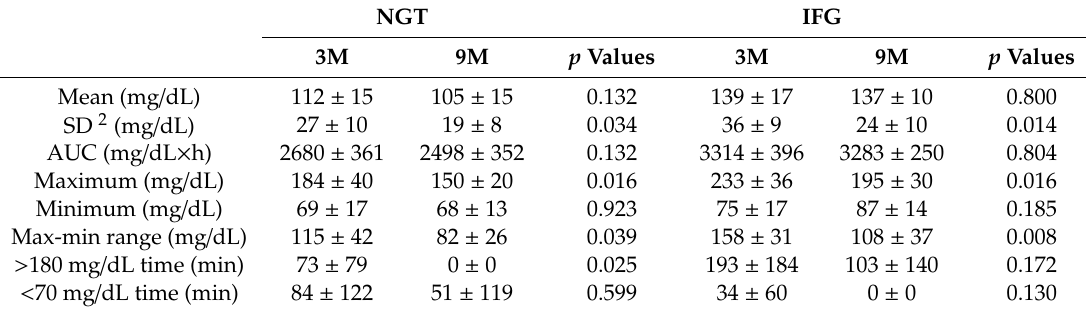
Table 2. 24-h glucose indices from CGMS 1 .